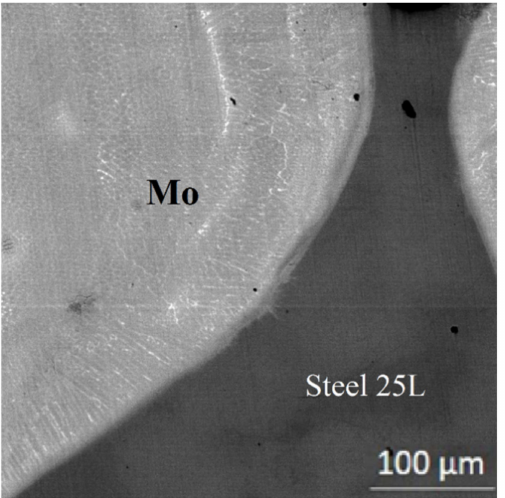
Figure 9. Microstructure of steel and molybdenum boundary after deposition.